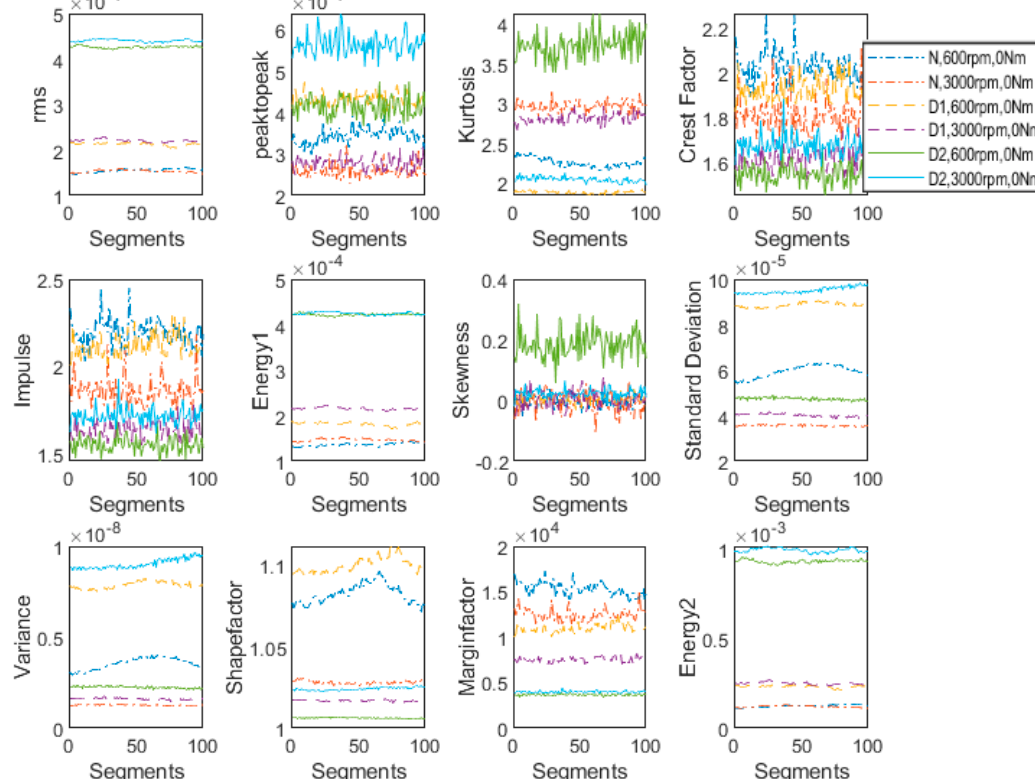
Figure 8. Features’ plot for normal, 1 tooth broken and 2 teeth broken gear boxes at constant load (0 Nm) and changing speed (600 and 3000 rpm).